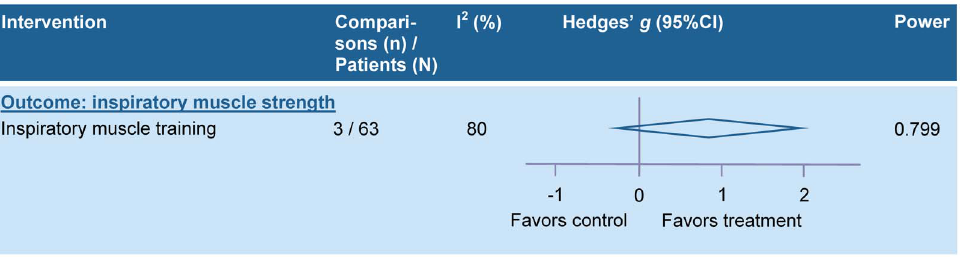
Figure 6. Summary effect sizes for physical therapy interventions – other: inspiratory muscle training. Legend: C, Control group; CI, Confidence interval; E, Experimental